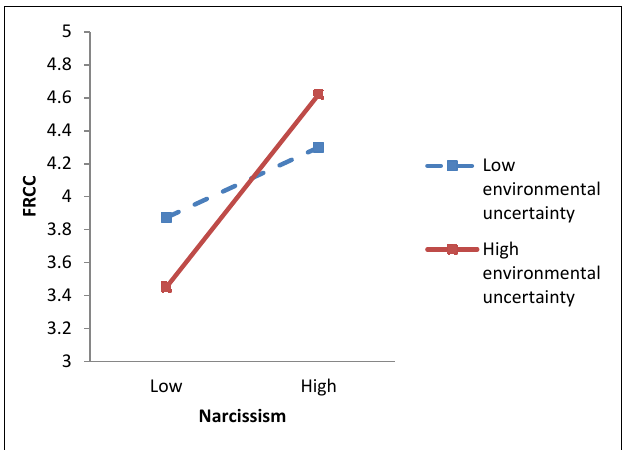
FIGURE 3 | Study 2 moderating effect of environmental uncertainty on the relationship between narcissism and felt responsibility for constructive